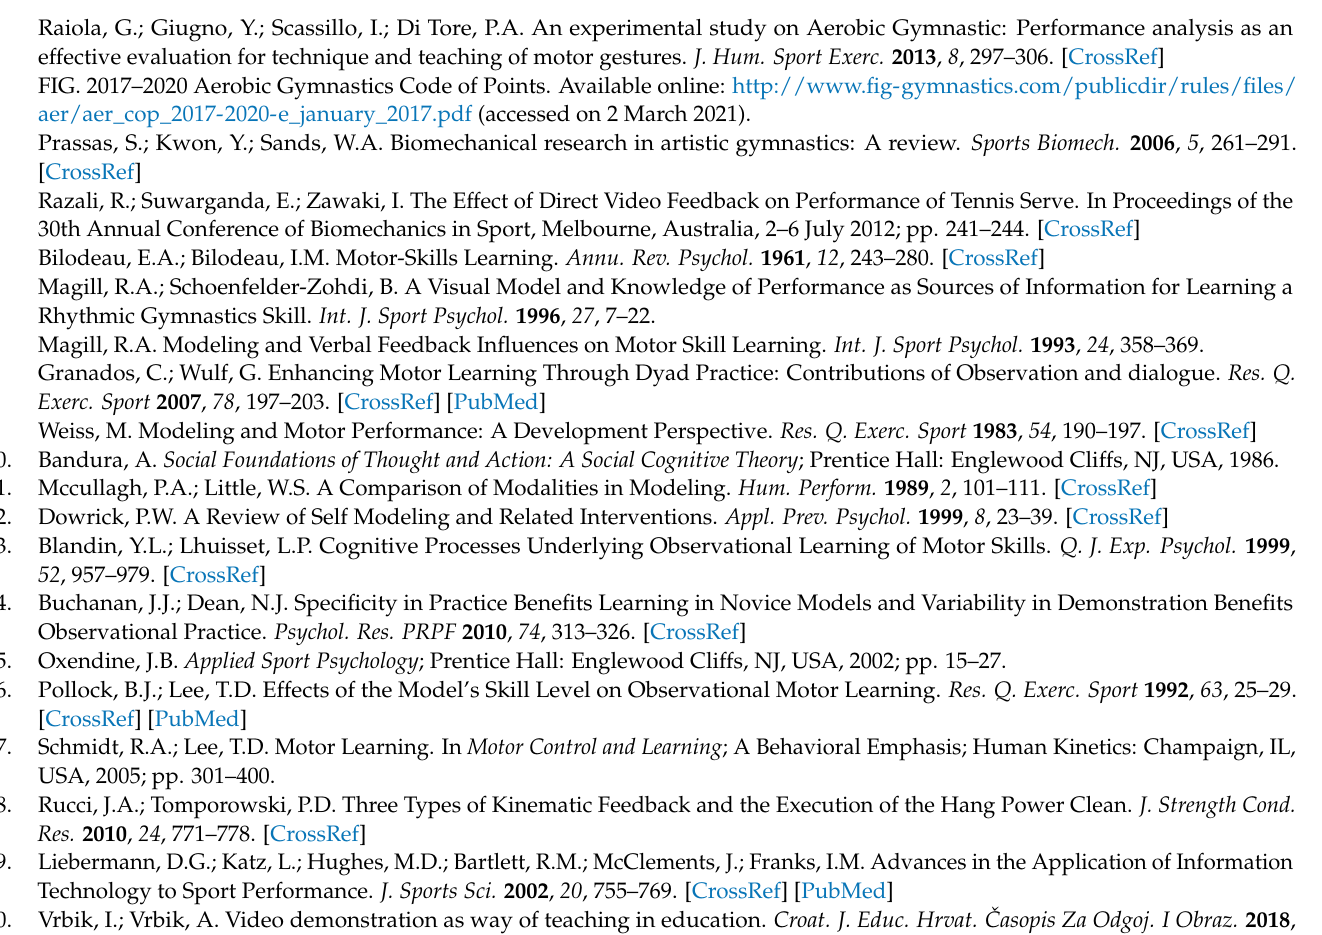
FIG. 2017–2020 Aerobic Gymnastics Code of Points. Available online: